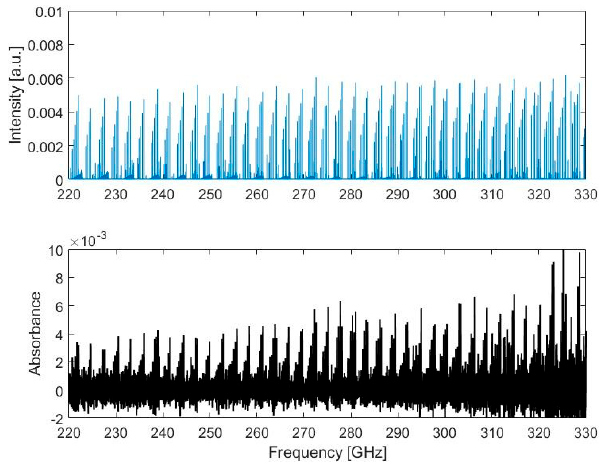
Figure 5. Comparison of measured absorbance (bottom) with line positions and intensities for the ground vibrational state simulated using PGOPHER [33] and the rotational constants of Cuisset et al. [27] in the total frequency range of current study (220 – 330 GHz).